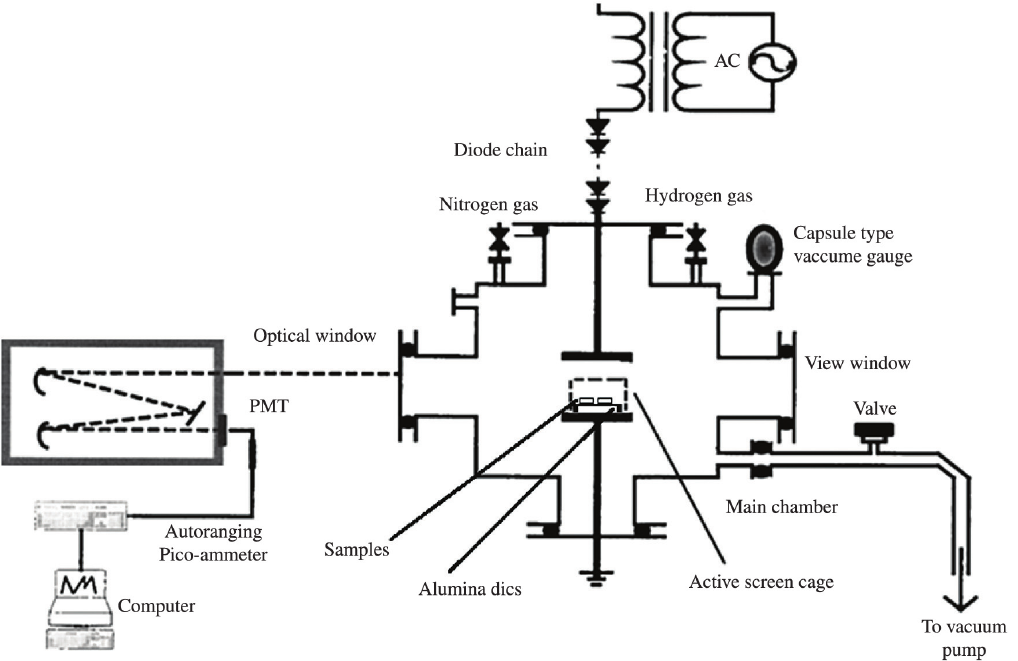
Figure1. Schematic diagram of experimental